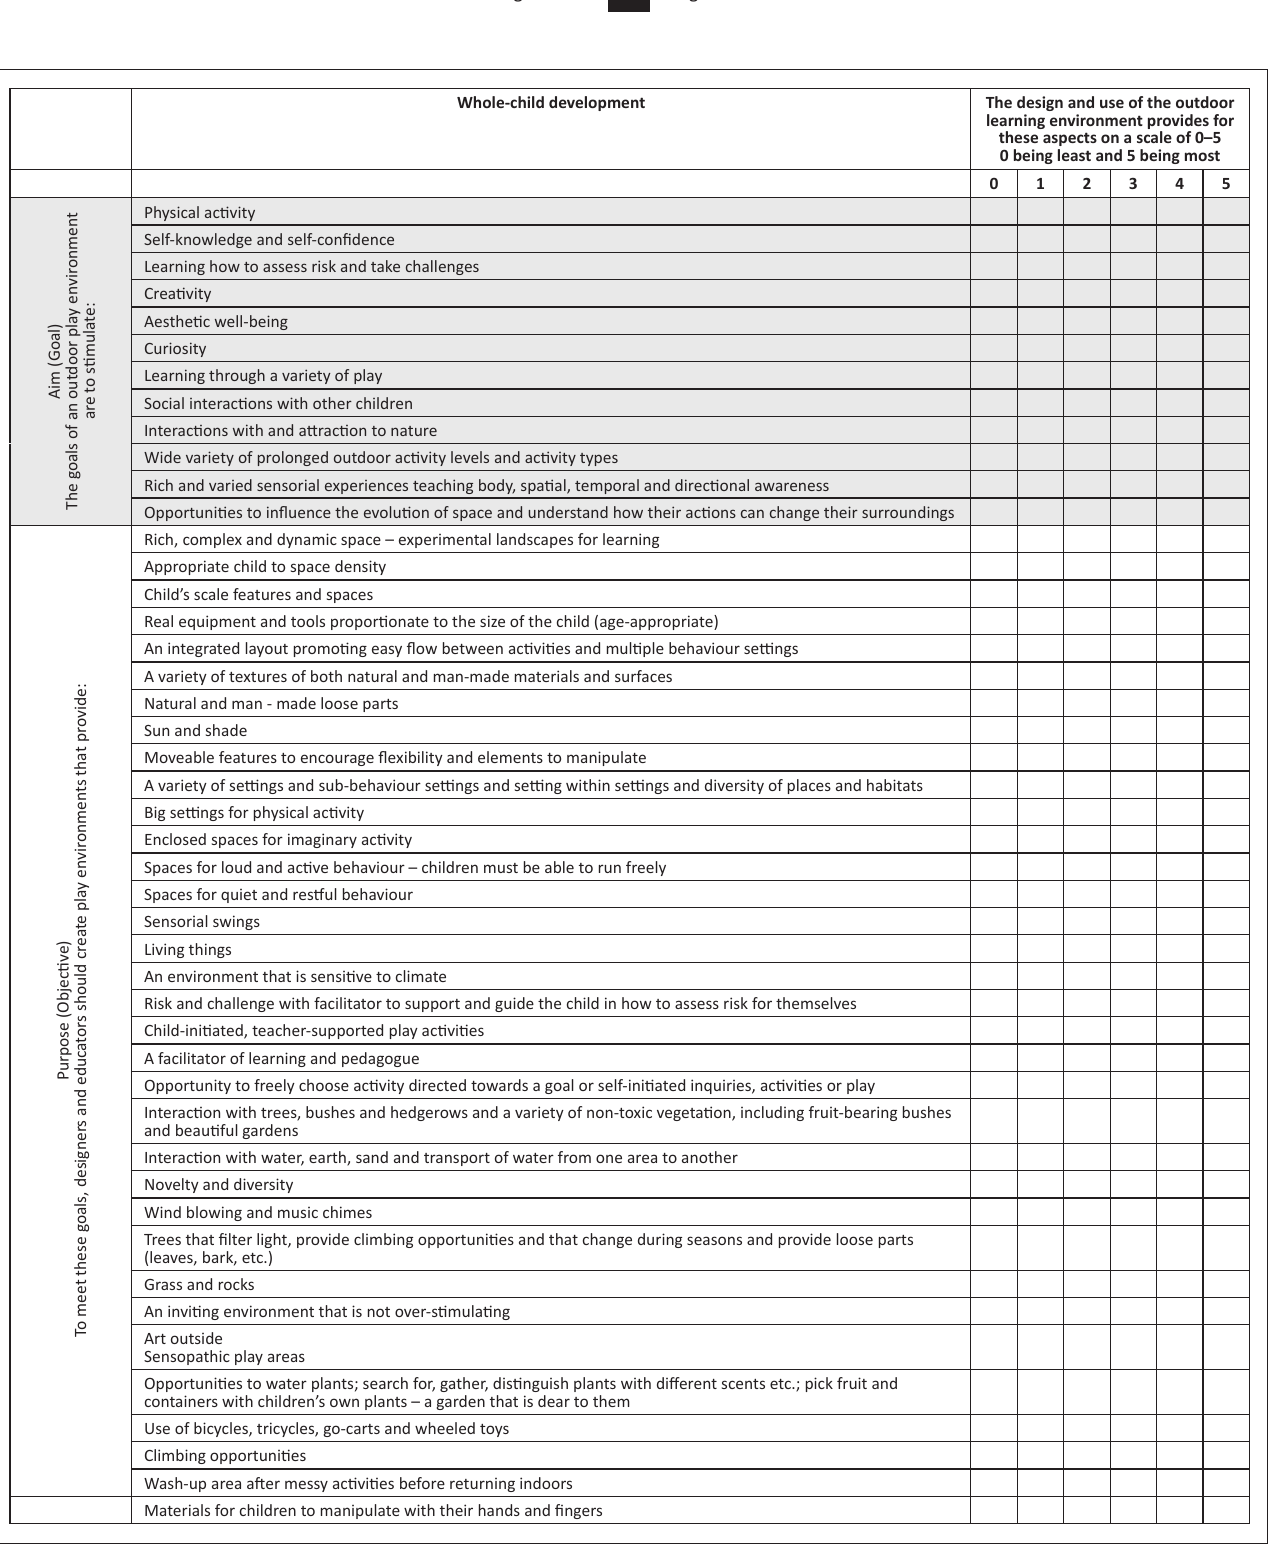
FIGURE 1: Checklist for the design and use of an outdoor learning environment for sensory and motor development as part of the whole child